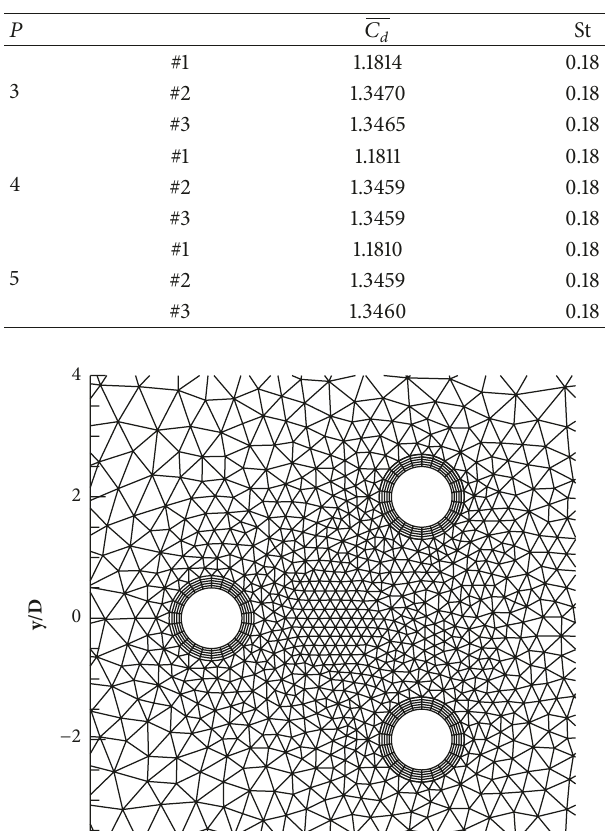
Table 2: Comparison of the mean drag coefficient and Strouhal number of flow around three cylinders.